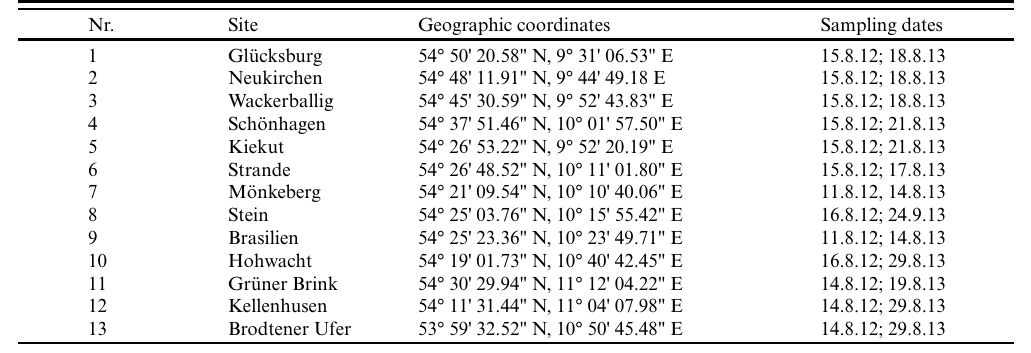
Table 1 . Geographic coordinates and sampling dates of sites sampled for the quantification and characterization of beach